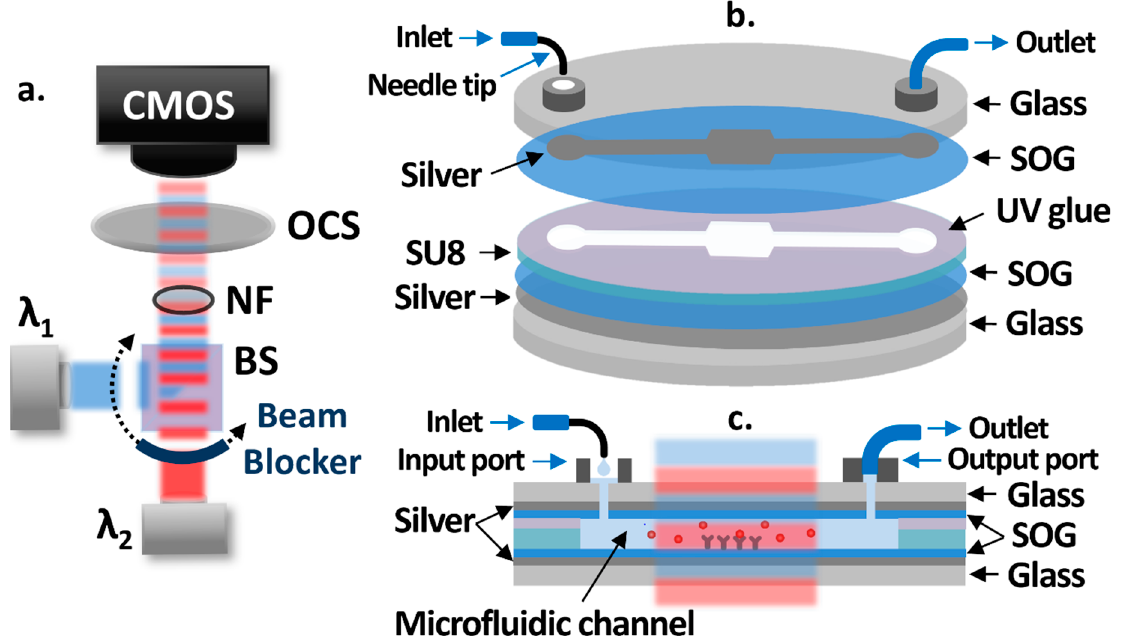
Figure 1. ( a ) Schematic diagram of the optical cavity-based biosensor (OCB) showing two laser beams at two different wavelengths ( λ 1 ( blue ) and λ 2 ( red )) alternatively propagating through the OCS with an interval of one second and reaching the CMOS camera. ( b ) Structure of the OCS showing each layer and connected input and output ports. ( c ) Cross-sectional view of the OCS showing the target biomolecule in a sample fluid being introduced into the microfluidic channel and attached to the receptor molecules on the SOG surface.